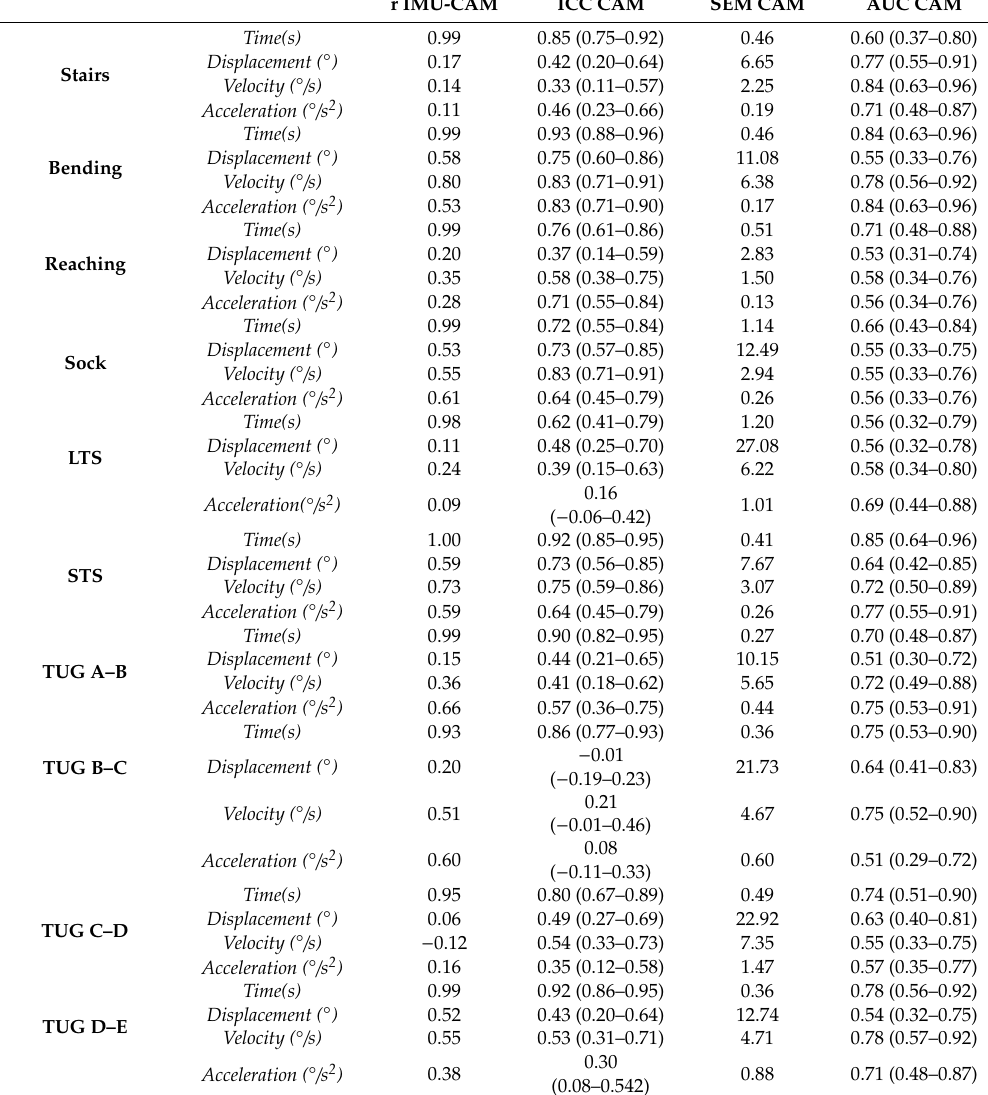
Table 3. Internal validity, reliability, and responsiveness outcomes from the variables extracted from the RGB-D camera. Inertial measurement unit (IMU); CAM. RGB-D camera; lie-to-sit (LTS);